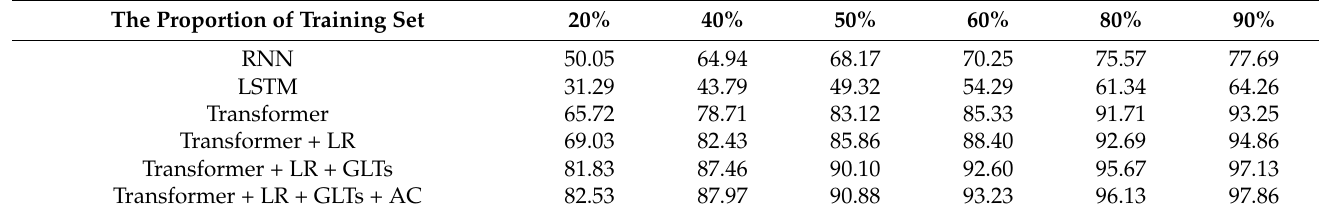
Table 3. Accuracy with different training set sizes (%).